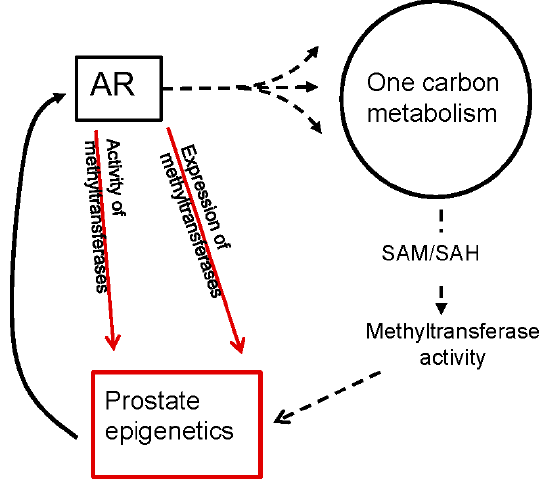
Figure 3. The impact of AR in prostate epigenetics. AR/androgen signaling can control the prostate epigenome: (1) indirectly by controlling expression of key enzymes involved in one-carbon metabolism and therefore the methylation potential of the cell (broken lines); or (2) directly by controlling the expression and activity of DNA and histone methyltransferases (solid lines).